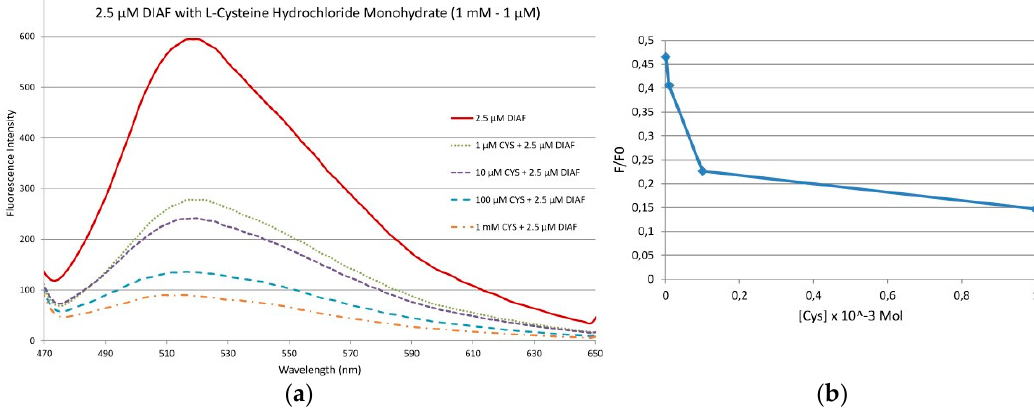
Figure 3. ( a ) Fluorescence emission spectra of Fluorescein Dialdehyde (2.5 µM) and L-Cysteine hydrochloride monohydrate (1 mM, 100 µM, 10 µM and 1 µM) excited at 460 nm in water, pH 9.5 at room temperature. The fluorescence intensity of DIAF decreases with increasing Cys concentrations. ( b ) F0 represents the maximum fluorescence intensity in the absence of analyte and F represents the corresponding intensity in the presence of